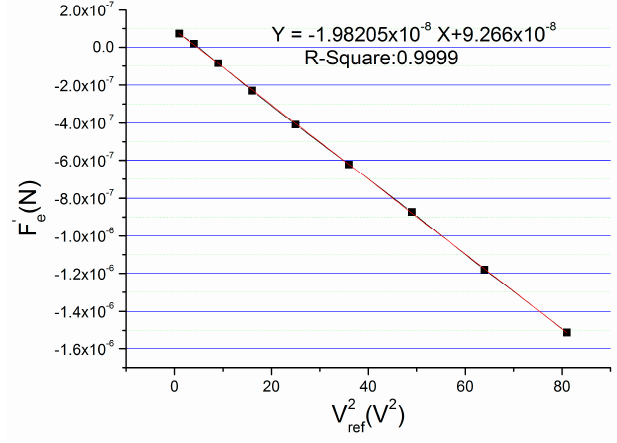
Figure 3. Relationship between V 2